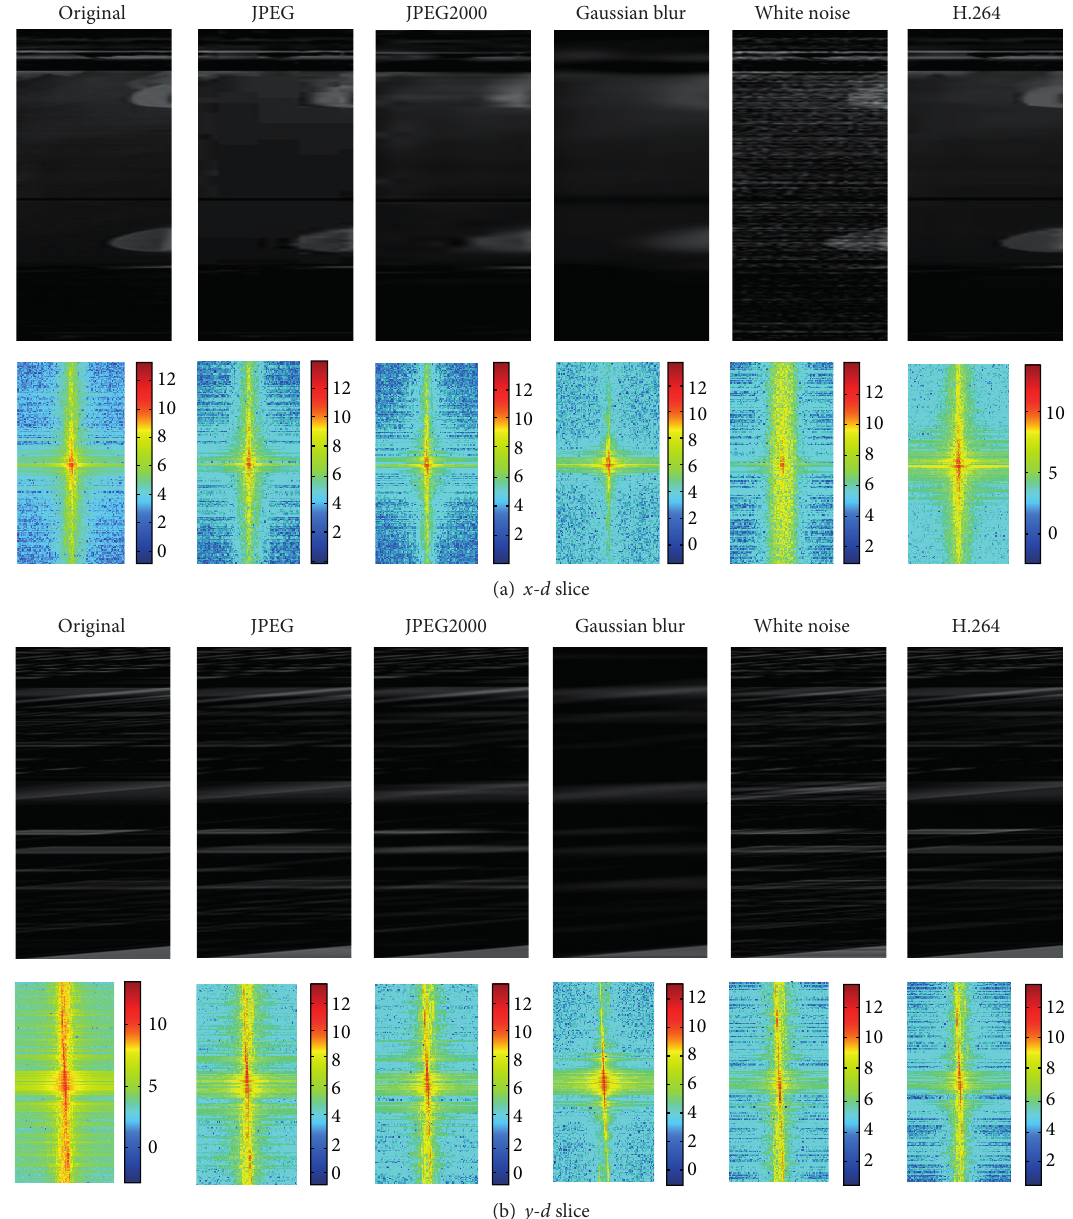
Figure 1: The figure of x - d and y - d cross-sectional views under different types of